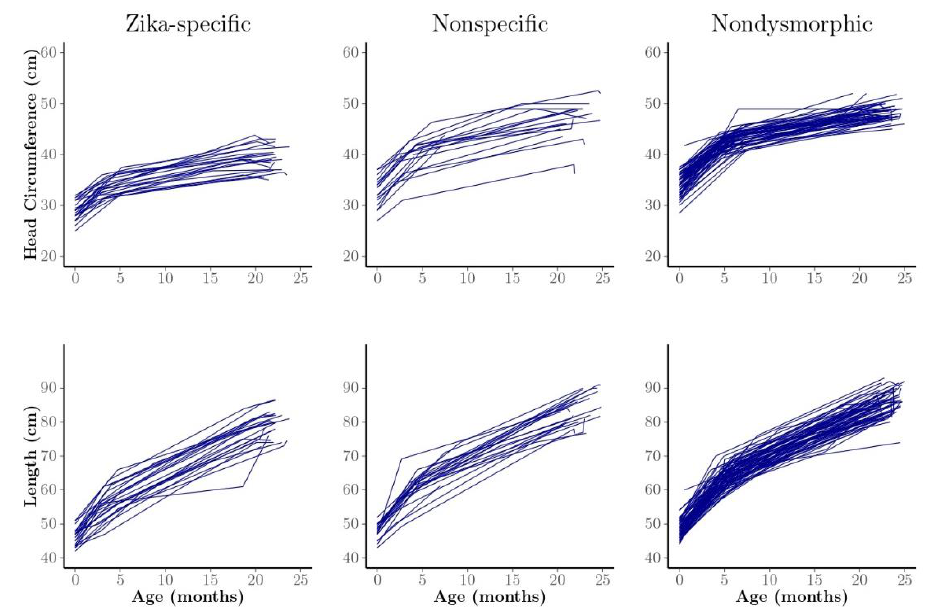
Figure 3. Profile plots of head circumference (HC) and length of observed individual children, generally measured three times at approximately birth, 1 − 7 months of age, and 24 months by phenotype group. We classified the children into three phenotype groups: Zika-specific, nonspecific dysmorphic, and nondysmorphic.